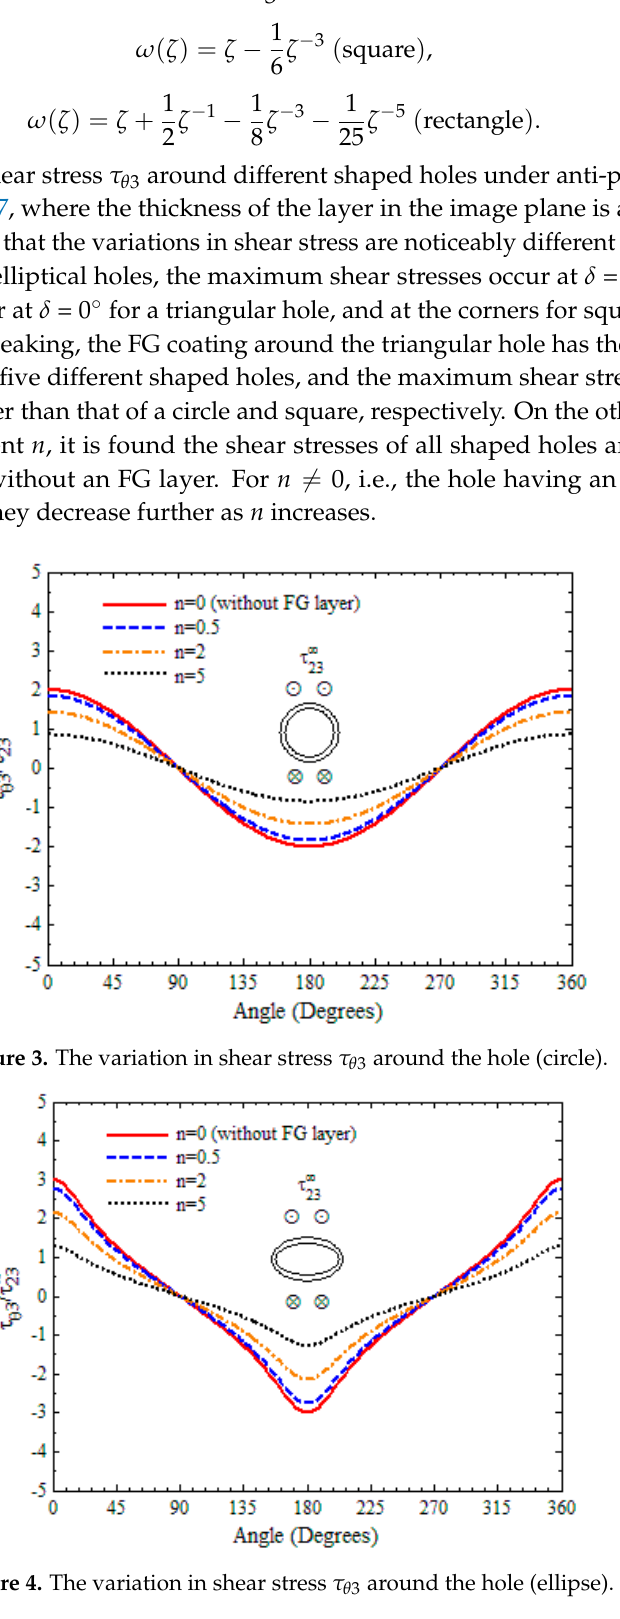
Figure 5. The variation in shear stress 3 θ τ around the hole (triangle).